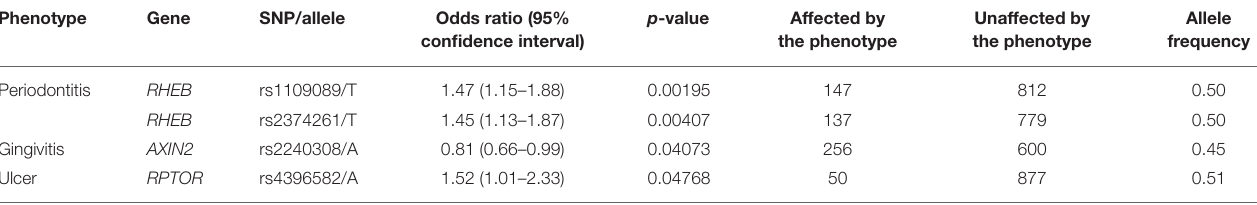
TABLE 3 | PheWAS summary results in the sample of White patients.